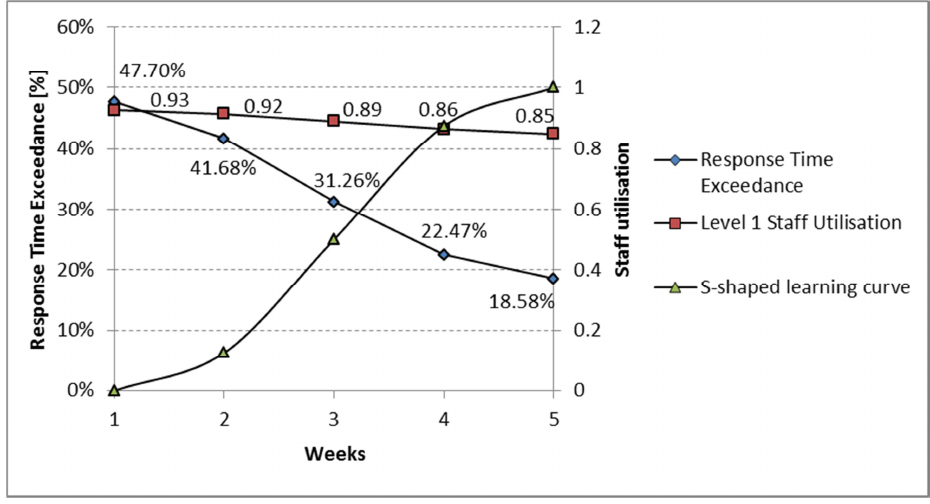
Figure 6 – Response time exceedance reduction by shortening the operational time by 8 % (staff number at Level 1 is